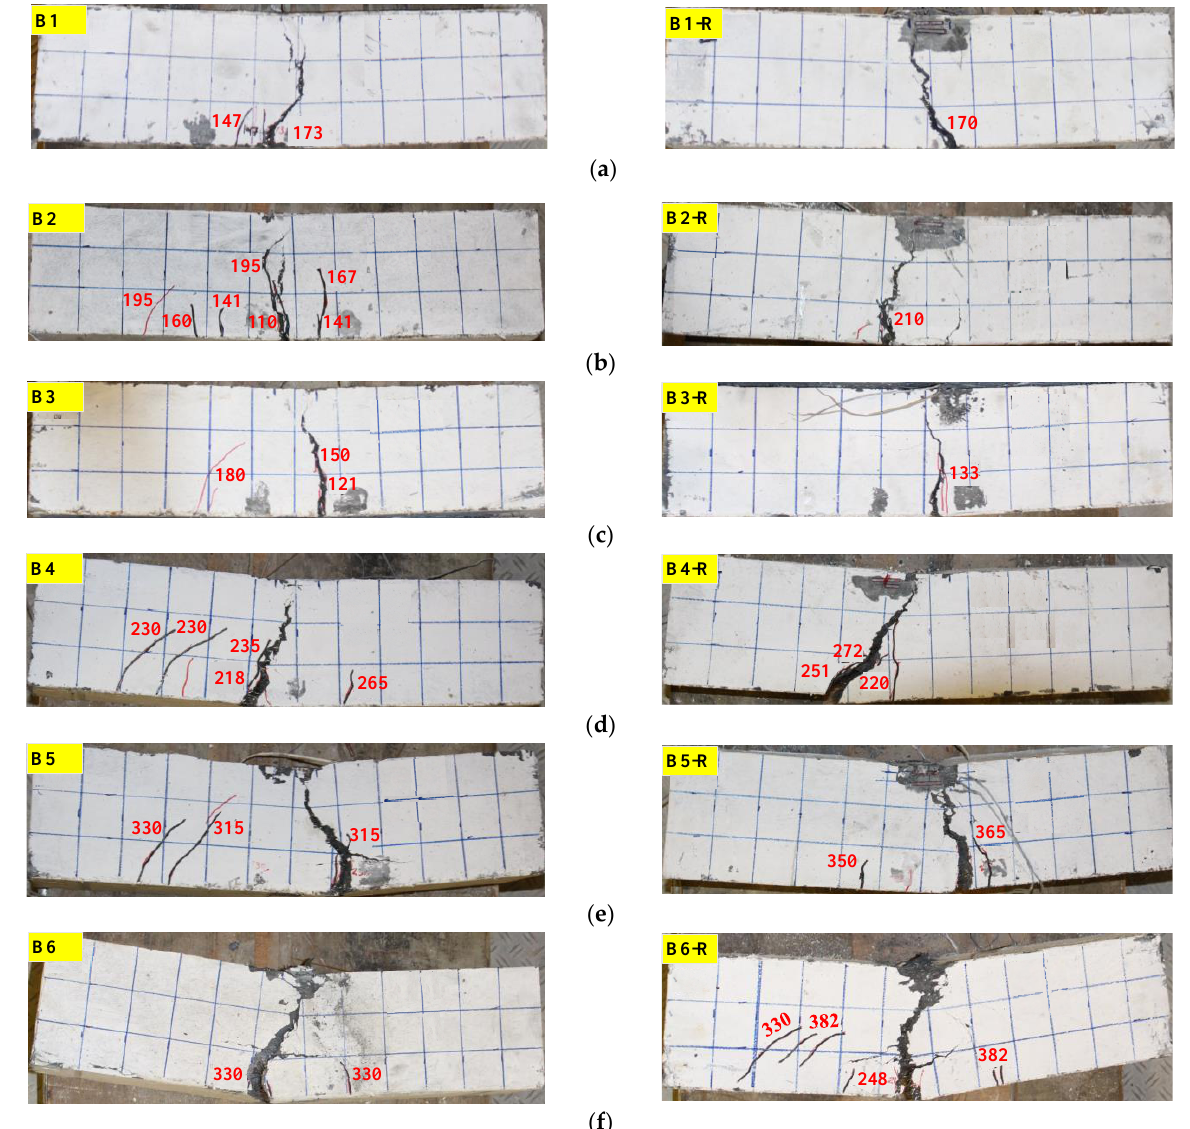
Figure 14. Failure patterns of ( a ) B1, ( b ) B2, ( c ) B3, ( d ) B4, ( e ) B5, and ( f ) B6.